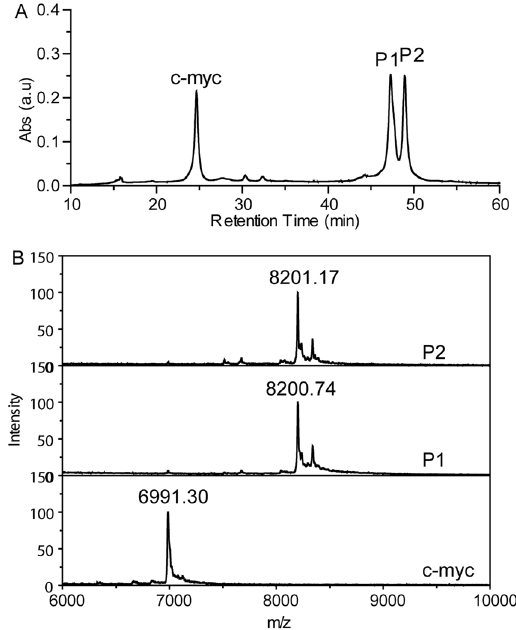
Figure 2. ( A ) HPLC analysis of the crudes from crosslinking reaction between Pt3 and c-myc GQ and ( B ) MALDI-TOF mass spectra of free c-myc GQ and the Pt3 -GQ adducts, P1 and P2